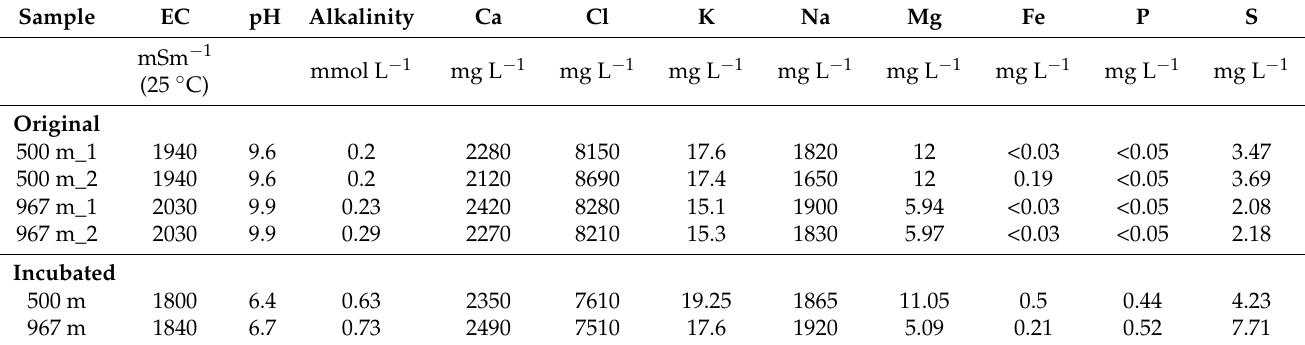
Table 2. Geochemistry of the original situation in fracture fluids and in the closed biofilm trap after 6 months incubation. Samples 1 and 2 represent